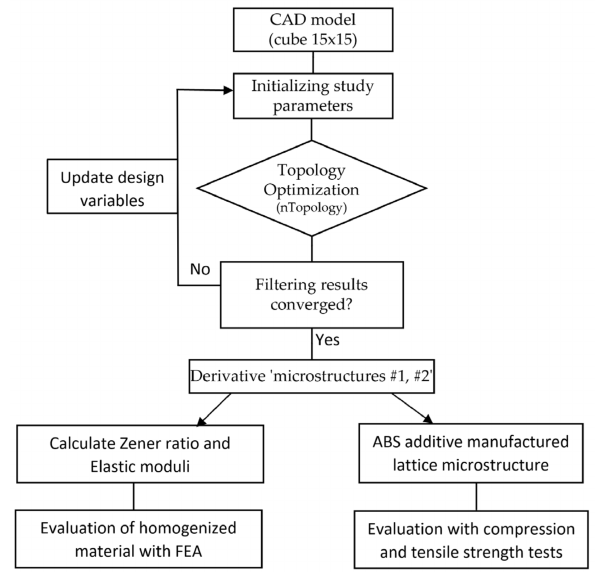
Figure 1. Adopted methodology